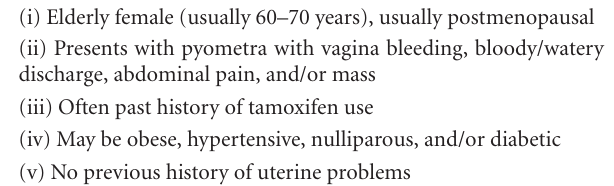
Table 1: Typical patient profile presenting with uterine carcinosar-